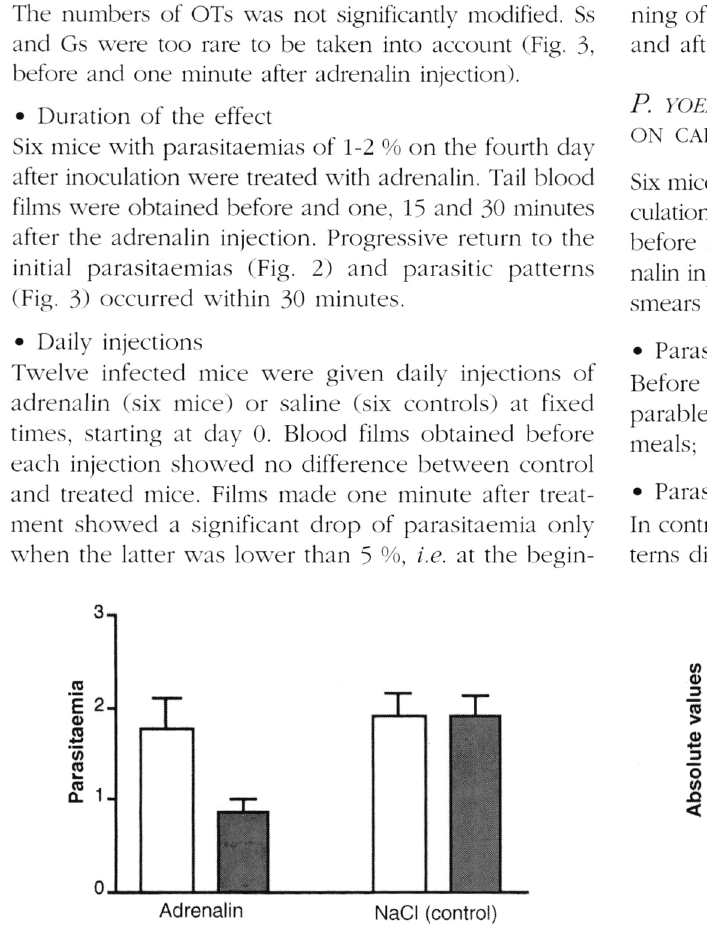
Fig. 1. - P. yoelii yoelii: immediate effect of adrenalin injection on parasitaemia in mouse tail blood. Box-plots represent parasitaemias and vertical bars indicate the upper limit of the standard error of the mean (SEM).